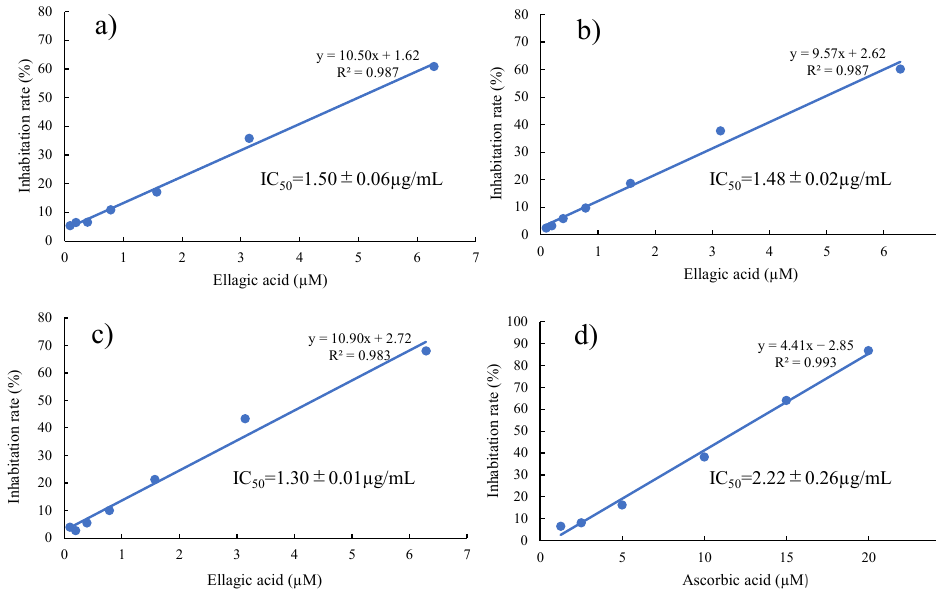
Figure 3. DPPH radical scavenging activity of EA/UR systems. Results are expressed as the mean ± S.D. (n = 3). ( a ) EA; ( b ) PM (EA/UR = 1/1); ( c ) EVP (EA/UR = 1/1); and ( d ) ASC.